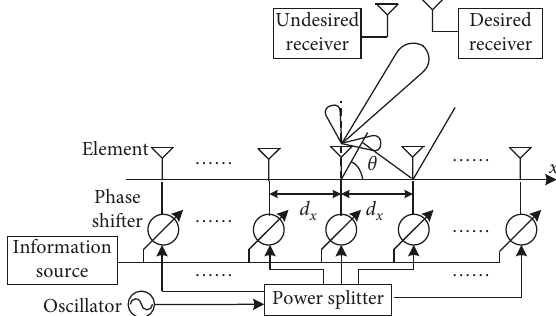
Figure 1: Structure of a DM